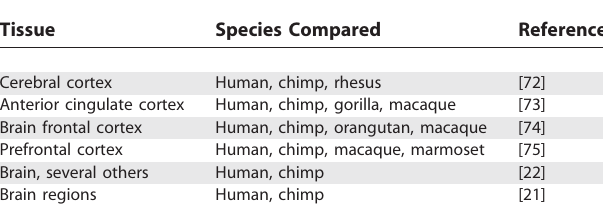
Table 2. Comparative Brain Gene Expression Studies Tissue Species Compared